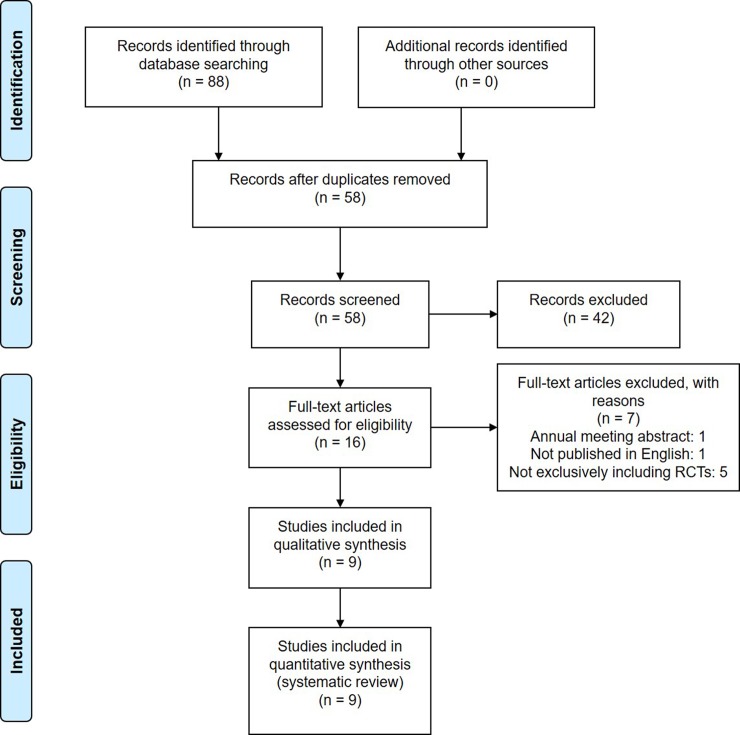
PRISMA flow diagram.